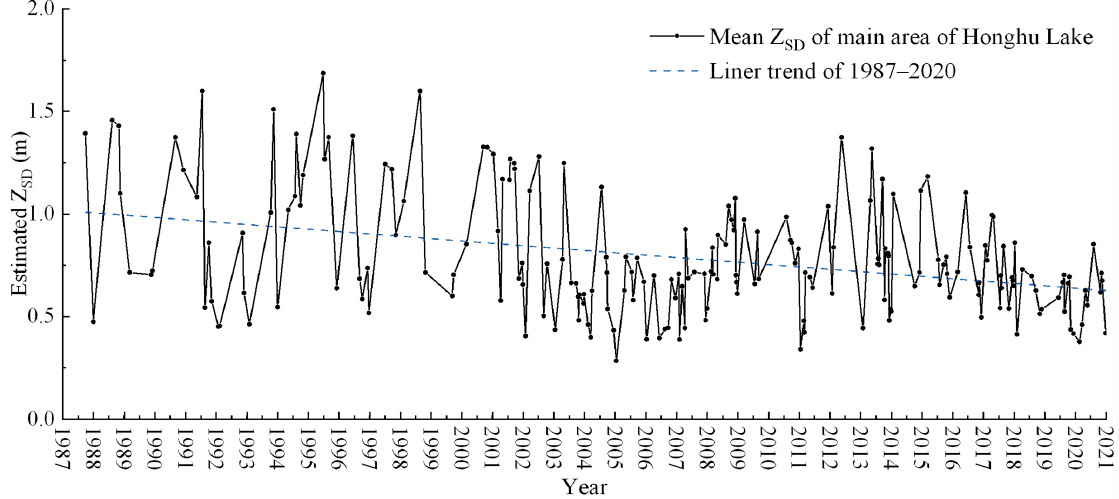
Figure 8. Time series of Landsat-estimated Z SD (mean value of the central lake area) from 1987–2020. There are 205 points in total, with a general downward trend.